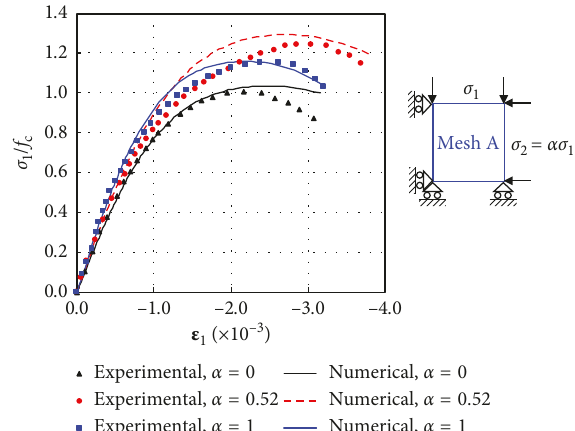
Figure 7: Computed stress-strain curves of concrete under biaxial compression.